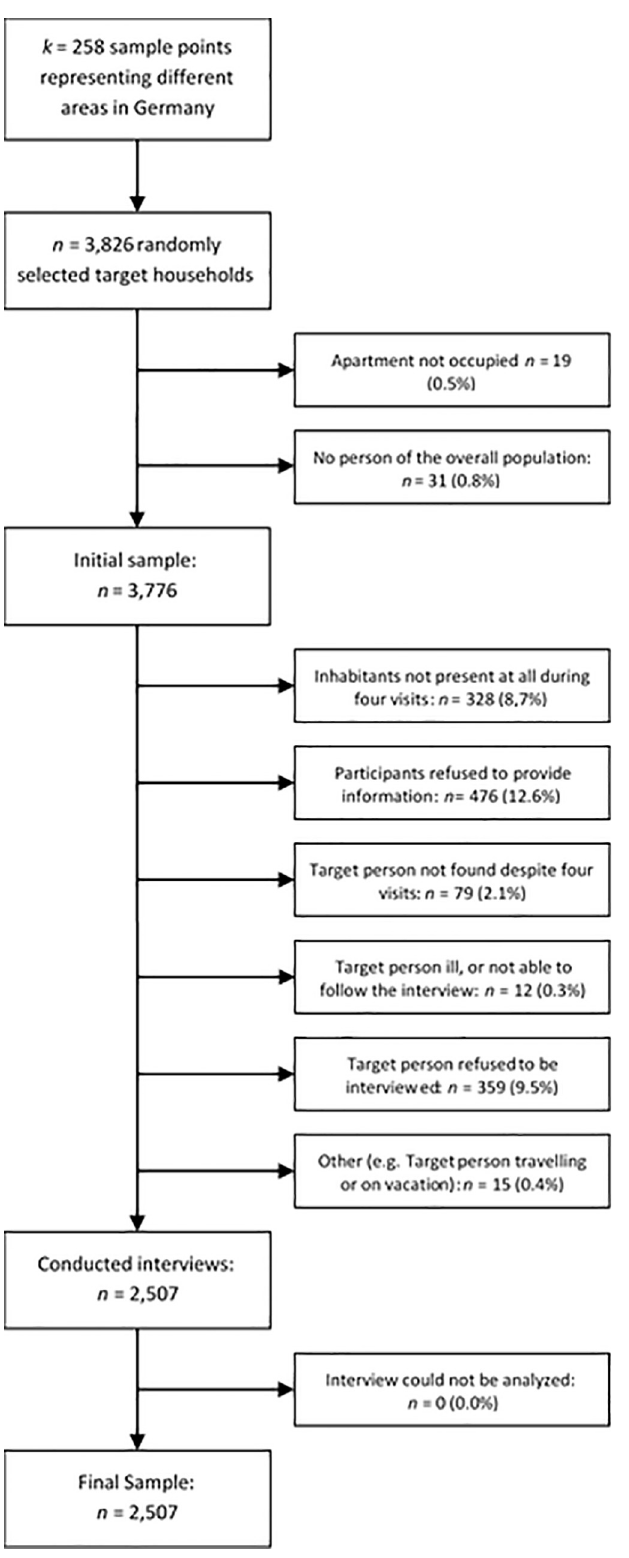
Fig 1. Flowchart of sampling procedure and reasons for nonparticipation.